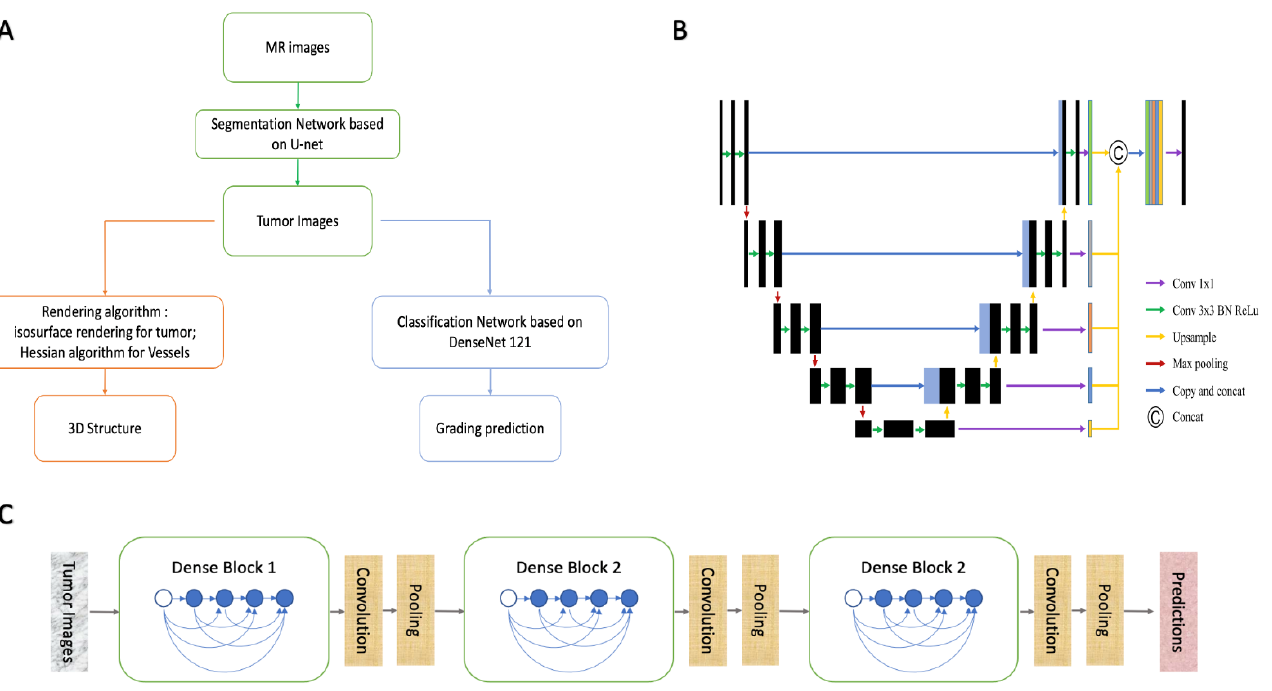
Figure 1. System structure designed in this research. ( A ). The cascade structure of system; ( B ). Network architecture of U-Net; ( C ). Network architecture of